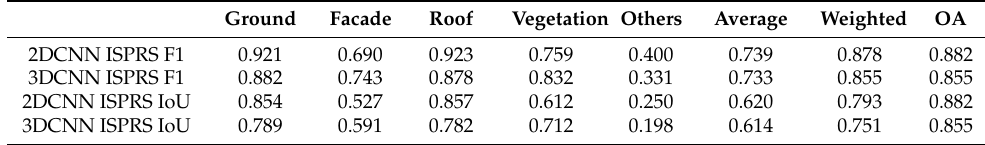
Table 19. F1, IoU with 2DCNN and 3DCNN classifiers trained on ISPRS Vaihingen dataset and predicted on Bordeaux dataset. The OA is also